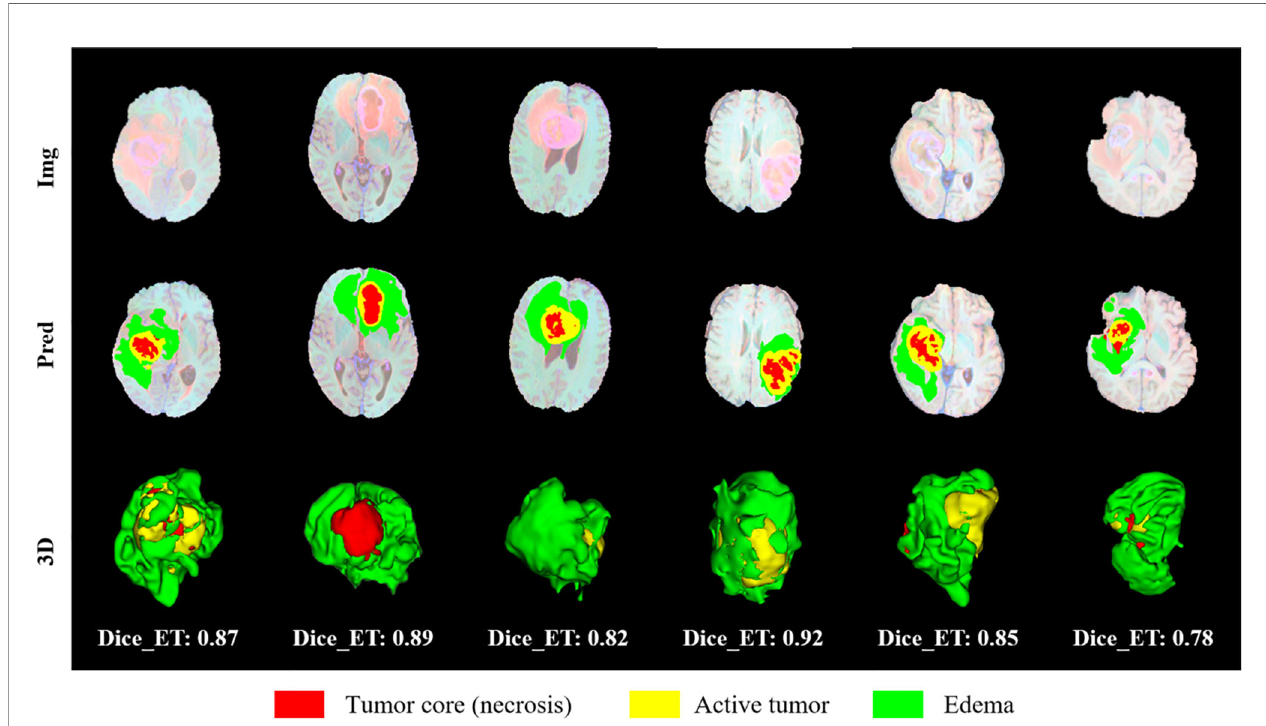
FIGURE 13 | Visual display of brain tumor segmentation results in validation set. Red color represents the tumor core (necrosis), yellow color represents the active tumor and green regions are the edema.